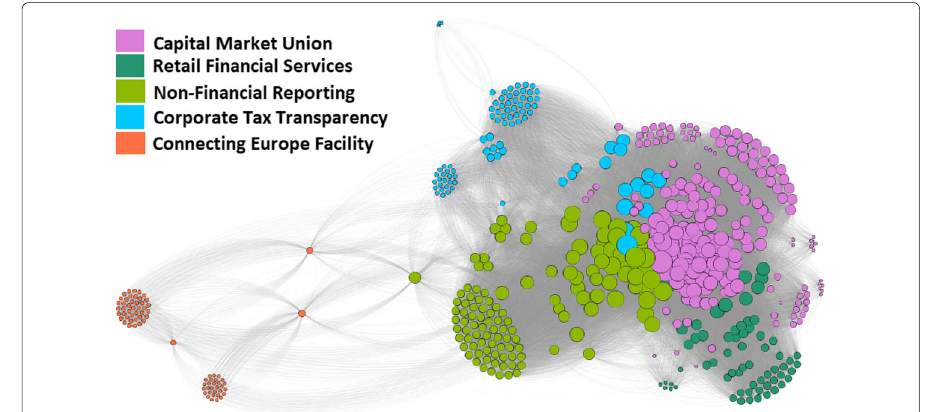
Fig. 1 Response network of the 565 lobby organizations. Two organizations are linked if they respond to the same consultation. Different colors denote the five detected communities. The communities are labeled by the prevailing topics in common consultations. Node size is proportional to the number of consultations to which the organization